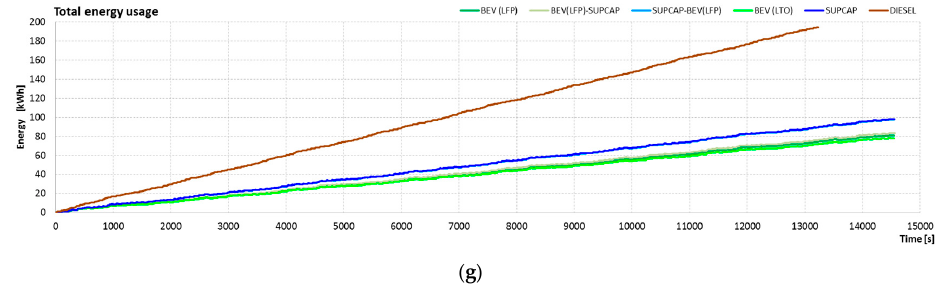
Figure 24. Results of simulation tests of powertrain systems on the Gdynia-Flat route on the section of about 100 km, where: ( a ) Bus speed during tests (km/h); ( b ) Voltage and Current on DC-link (V), (A); ( c ) Motor/Engine Power (kW); ( d ) Battery & SUPCAP State of Charge (%); ( e ) Battery & SUPCAP